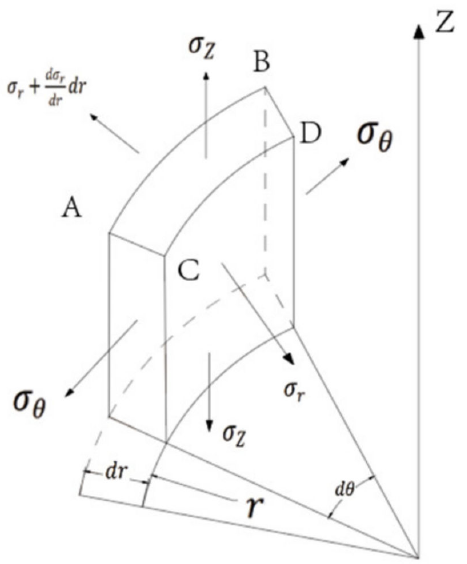
Figure 3. Three-dimensional microelement body of thick-walled cylinder.